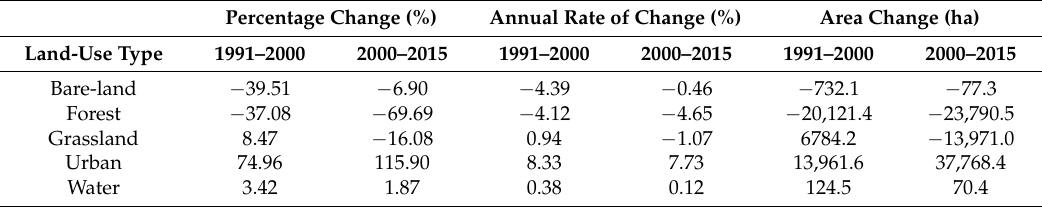
Table 4. Land-use percentage change and rate of change during the two study periods. Percentage Change (%) Annual Rate of Change (%) Area Change (ha)